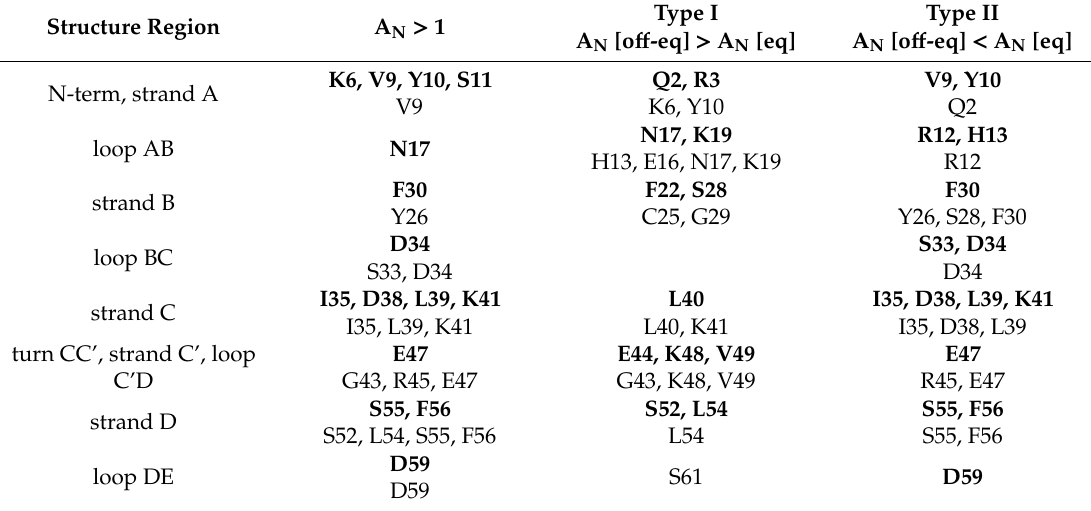
Figure 2. Overlay of the A N values obtained from 1 H- 15 N HSQC spectra of 8 µ M β 2m + 60 nM gold nanoparticles (AuNPs) in the presence of 0.8 mM Tempol, with a relaxation delay of 0.5 s ( blue ) or 5 s ( red ). The β -strand location and naming along the sequence is reported with yellow strips. The cartoon on the right highlights the positions of the accessible amides ( red ), i.e., exhibiting A N [eq] > 1, and the amides with Type II deviation of A N [o ff -eq] ( blue ), i.e., displaying A N [o ff -eq] < A N [eq]. The magenta color denotes sites where both A N [eq] > 1 and Type II deviation occur simultaneously. The secondary structure elements of β 2m are indicated according to the crystallographic naming scheme (PDB code 3HLA). Table 3. Paramagnetic perturbation induced by 0.8 mM Tempol on the amide NMR signals of 8 µ M β 2m with 60 nM AuNPs. The equilibrium (column 2) and o ff -equilibrium (columns 3 and 4) data are reported in bold. The corresponding data obtained without AuNPs (Table 2) are reproduced below in plain